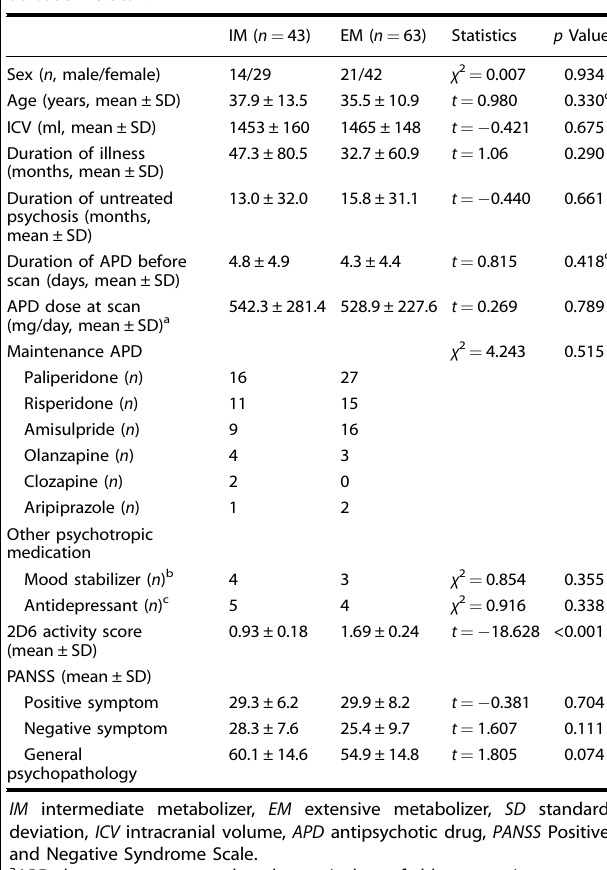
Table 1. Sociodemographic and clinical characteristics of all subjects at baseline scan.